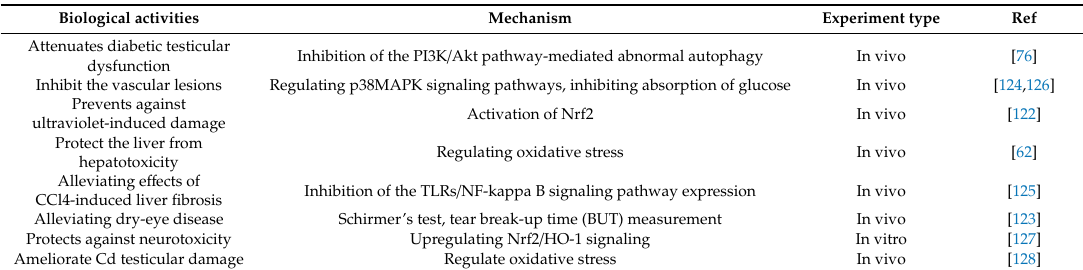
Table 7. Other biological activities and mechanism of